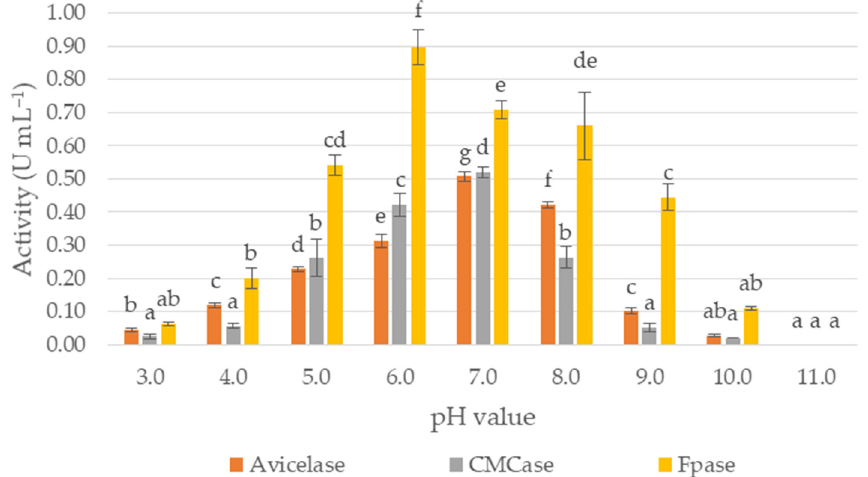
Figure 4. Effect of temperature on cellulase (CMCase, FPase, Avicelase) activity of Bacillus sp. 8E1A. Different letters above the bars (a, b, c…) indicate statistically significant differences among cellulases’ activity at different temperatures.